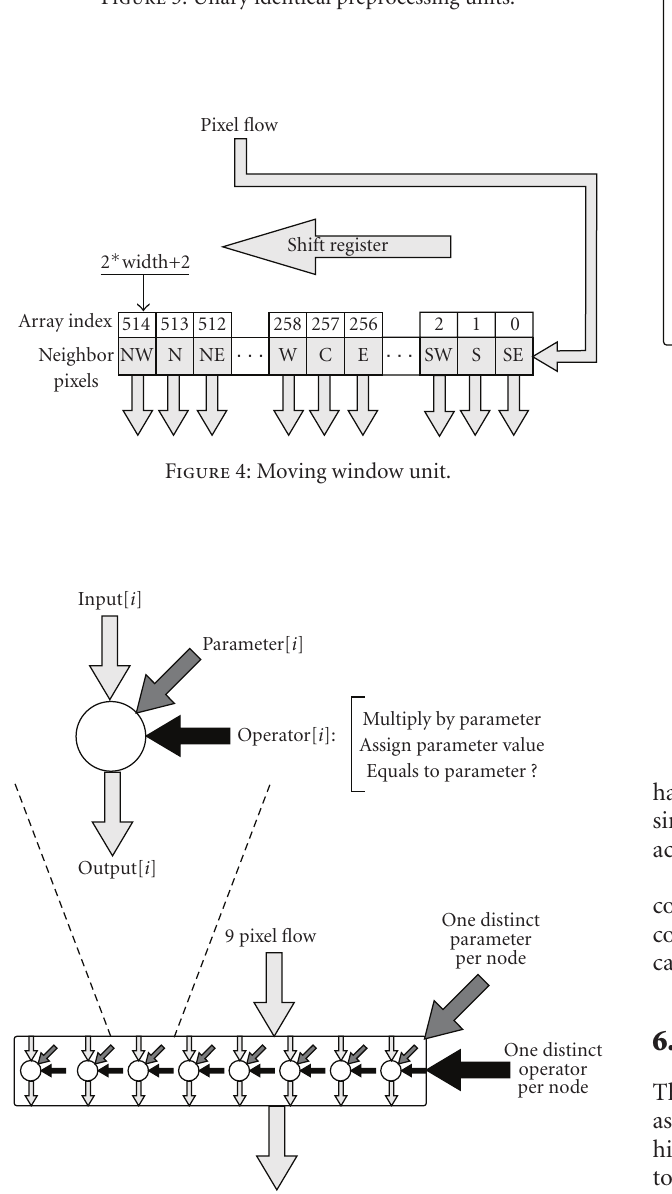
Figure 5: Unary di ff erential processing unit.